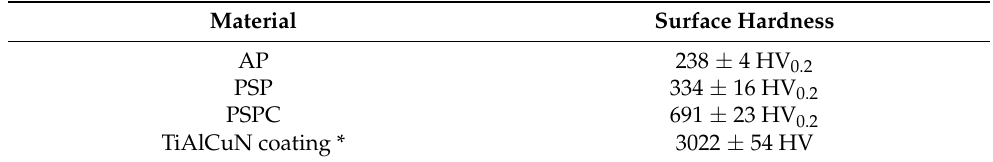
Table 6. Results obtained from impact testing.